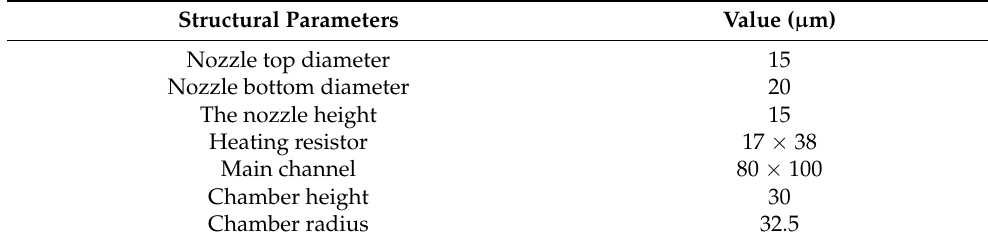
Table 1. The design parameters of the hemispherical inkjet